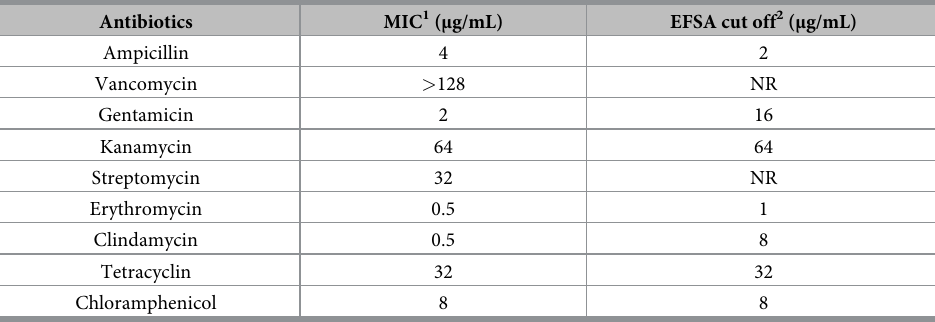
Table 3. Antibiotic resistance of Lactiplantibacillus plantarum PMO 08.